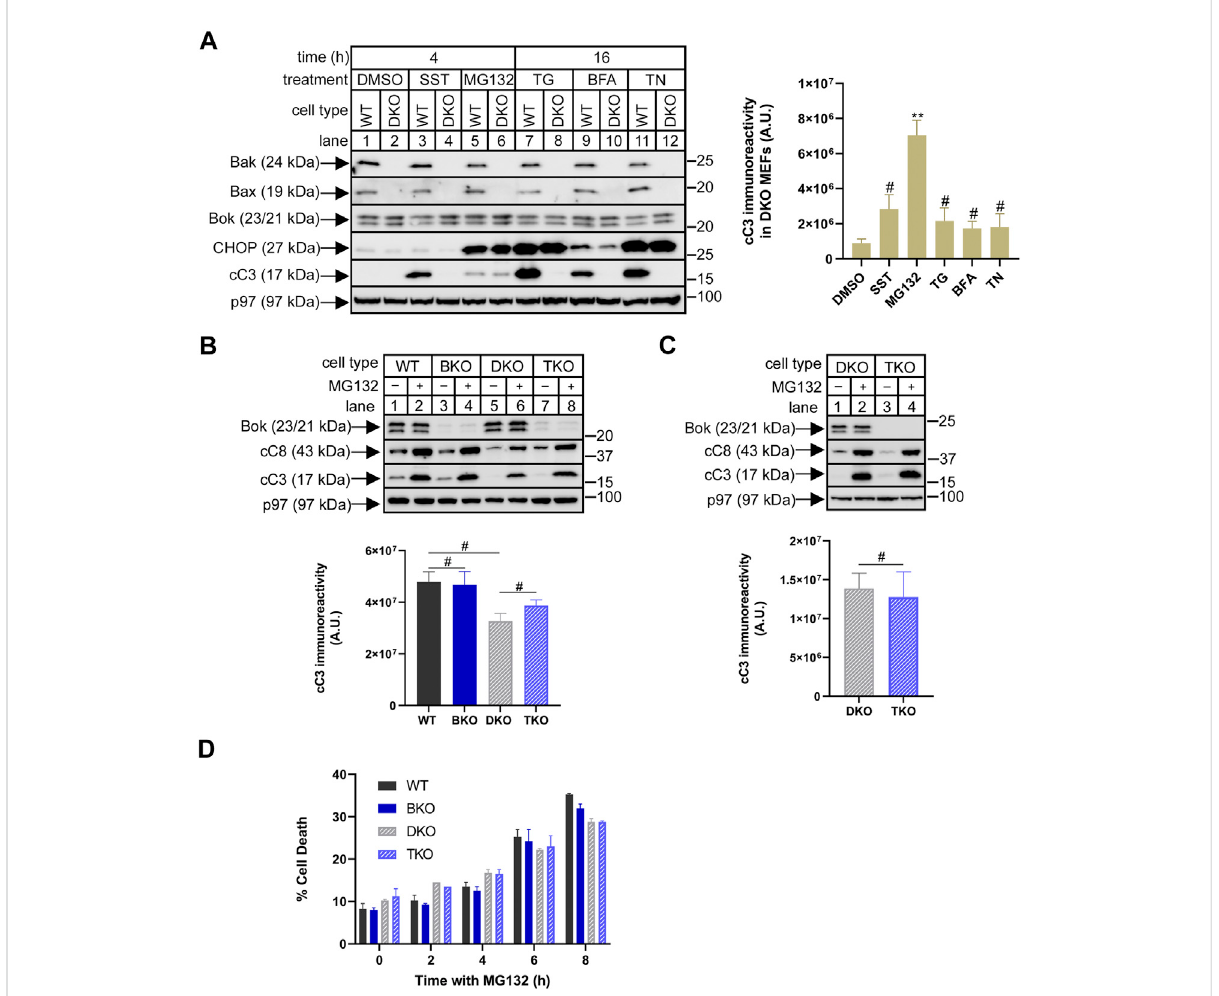
Bok doesnot mediate MG132-inducedapoptosis in Bak/Bax-de fi cient MEFs. (A) , WT and Bak/Bax double-knockout(DKO) MEFs (odd and even numbered lanes, respectively) were incubated as indicated with DMSO (vehicle), 1 µM staurosporine (SST), 10 µM MG132, 1 µM thapsigargin (TG), 0.5 μ g/ml brefeldin A (BFA), or 0.5 μ g/ml tunicamycin (TN), and cell lysates were probed in immunoblots for the proteins indicated, with p97 serving as a loading control and CHOP as a marker of ER stress. The histogram shows quantitated cleaved caspase-3 (cC3) immunoreactivity in DKO MEFs (mean ± SEM n =4, ** designates p < 0.005and # designates not signi fi cant, p > 0.05, for responses to SST,MG132, TG, BFA,and TN vs.DMSO control). (B,C) , Using CRISPR/Cas9, Bokwas deleted fromeither WTor DKOMEFs, creatingBok KO(BKO) andtripleKO